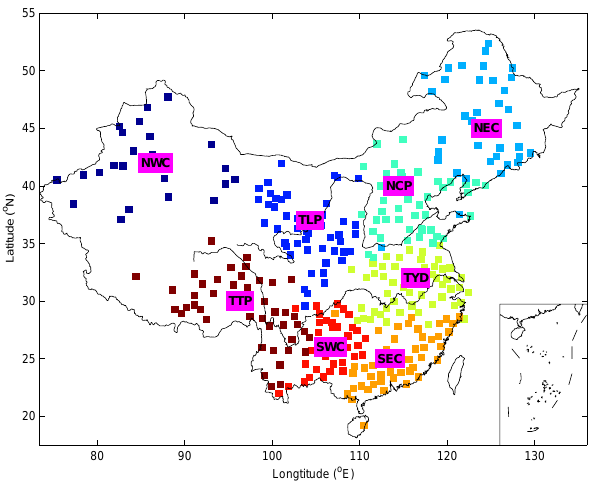
Fig. 1. Spatial distribution of 332 surface observation stations in China used in the analysis. Eight regions are classified using a fac- tor analysis with varimax rotation including (1) Northwest China (NWC), (2) the Loess Plateau (TLP), (3) Northeast China (NEC), (4) the North China Plain (NCP), (5) the Yangtze Delta region (TYD), (6) Southeast China (SEC), (7) Southwest China (SWC), and (8) the Tibetan Plateau